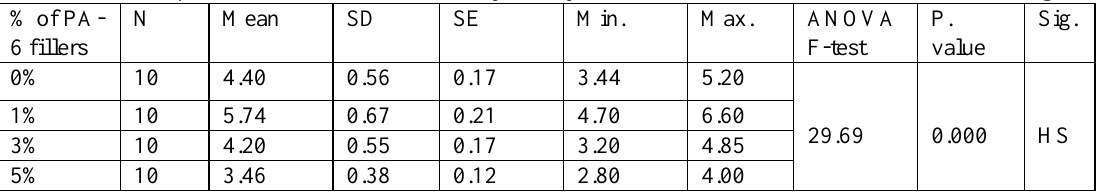
Table (3): Descriptive statistics and ONE -way Analysis of variance (ANOVA) for tensile strength test % of PA-